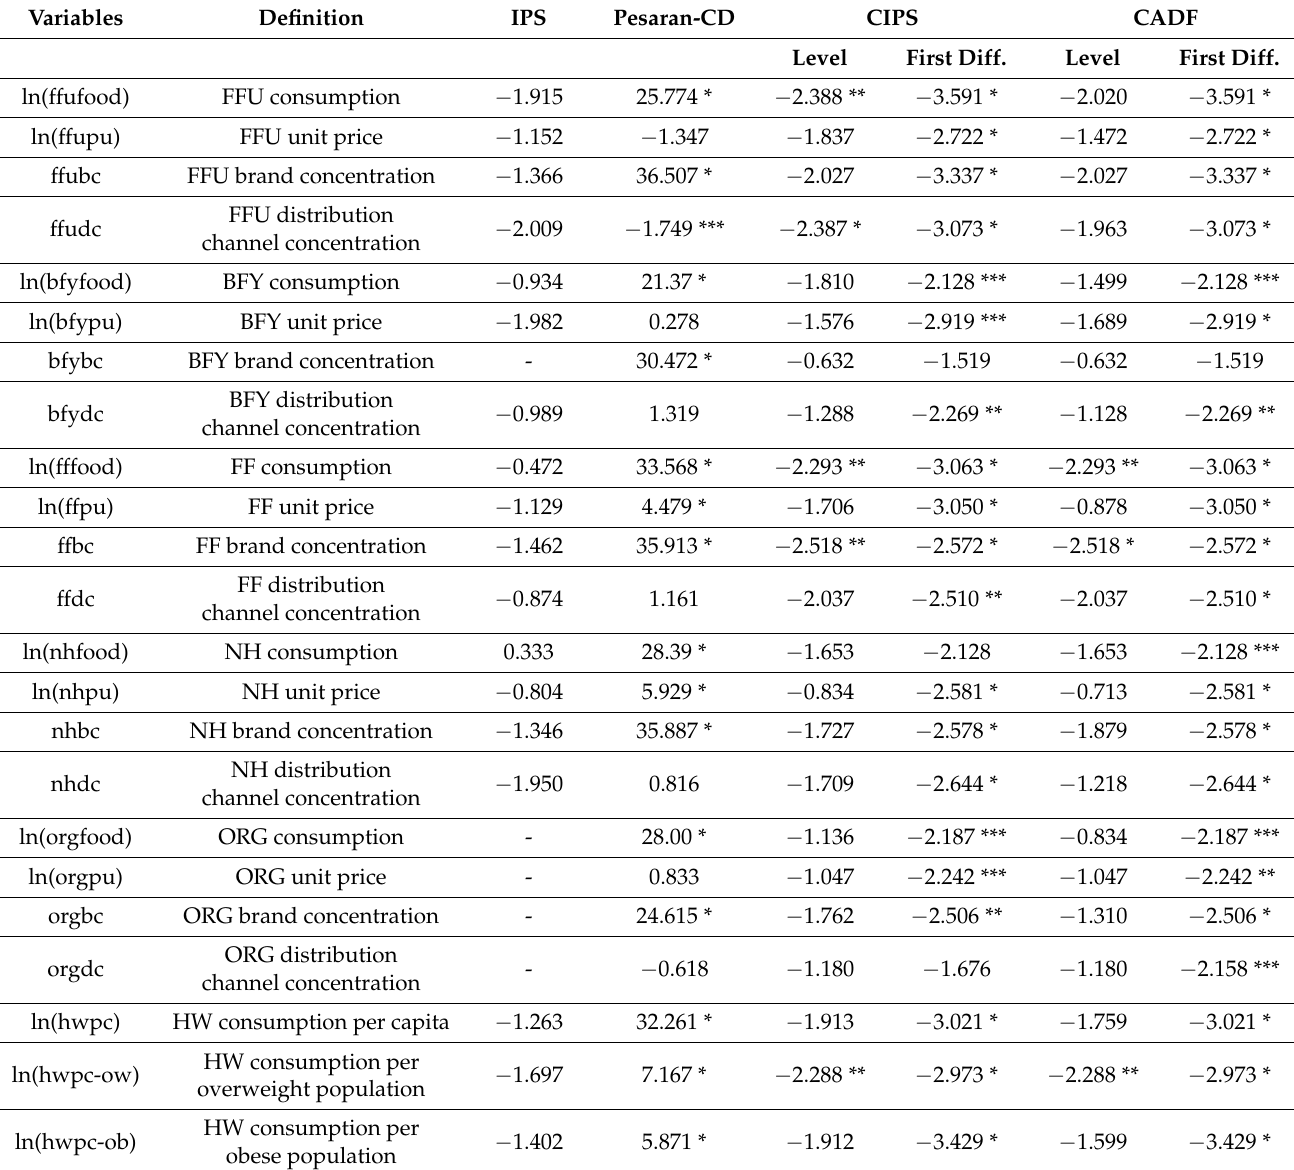
Table A1. First- and second-generation Panel unit root tests for alternative estimates.